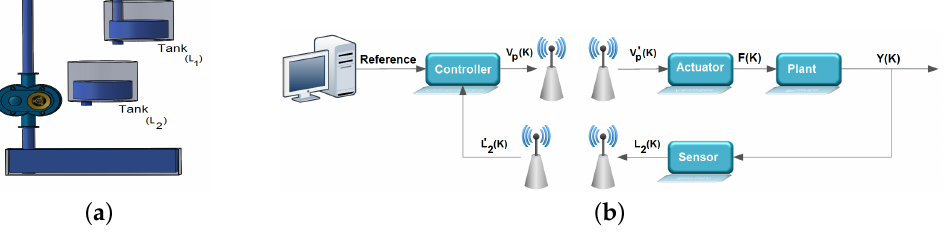
Figure 3. ( a ) System coupled tanks; ( b ) diagram of the control system adopted in this work.